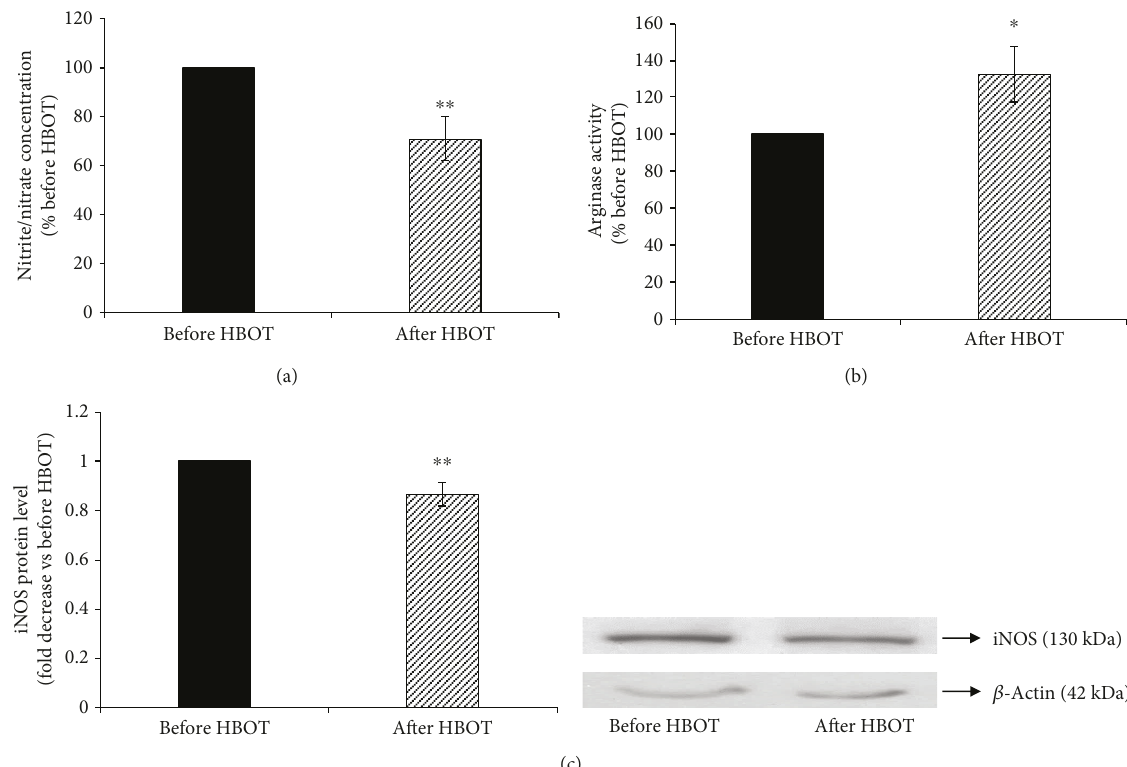
Figure 2: Changes in the serum nitrite/nitrate concentration, arginase activity, and iNOS protein level in lymphocytes after HBO exposure. (a) The serum nitrite/nitrate concentration was expressed as a % before HBOT; (b) the serum arginase activity was expressed as a % before HBOT; (c) level of iNOS protein in lymphocytes, normalized to β -actin and expressed as fold change before HBOT (arbitrary control set at 1). Inset: representative Western blots ( n = 11 – 13 ); ∗∗ p < 0 01 ; ∗ p < 0 05 . iNOS: inducible nitric oxide synthase. Other abbreviations are